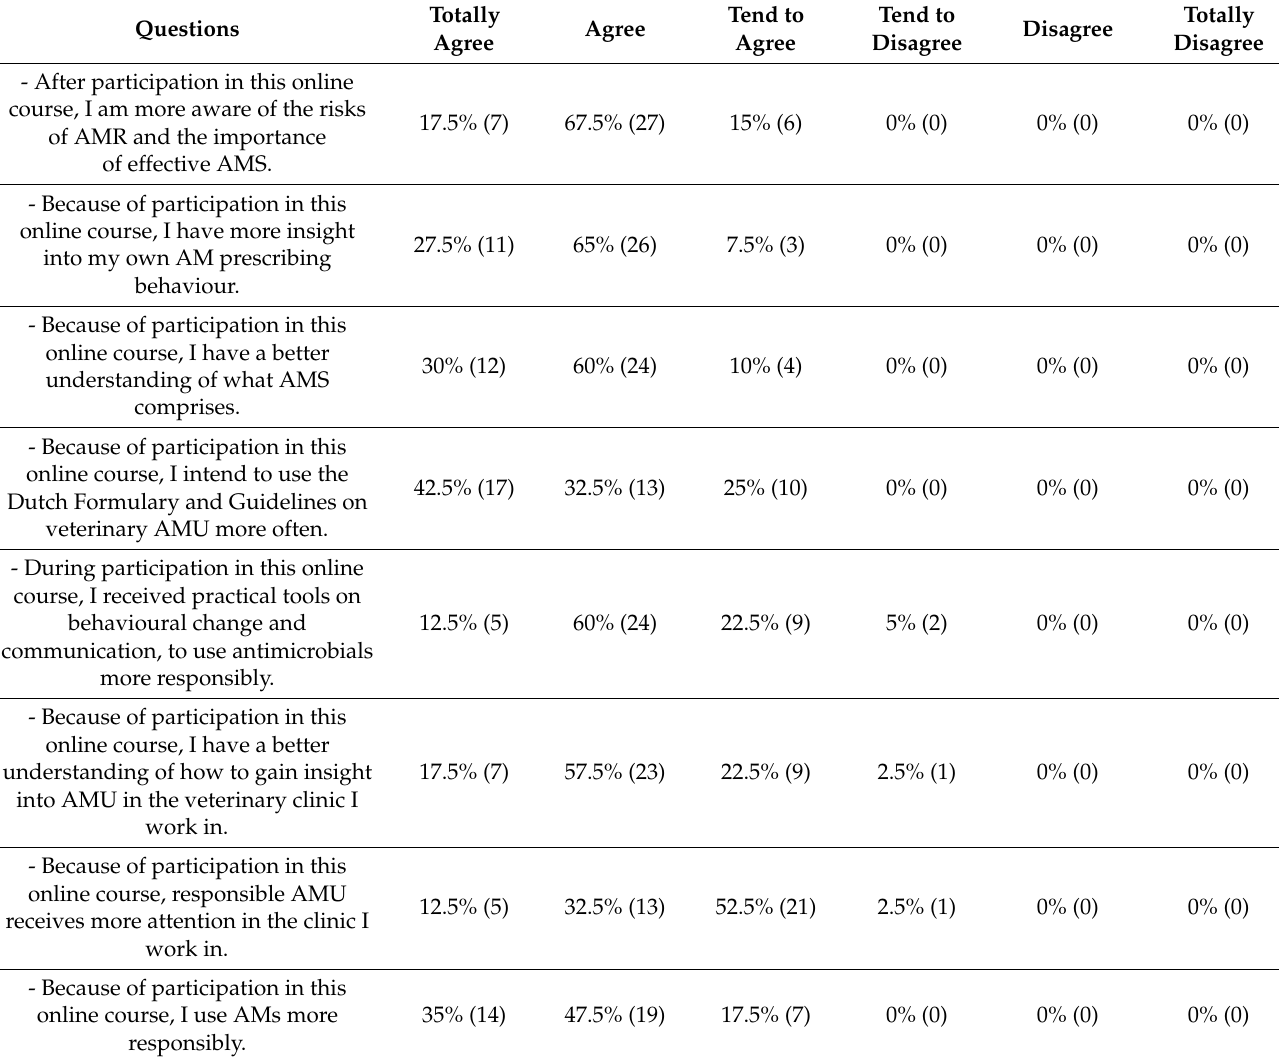
Table 2. Questions to evaluate achievement of the learning objectives of the online course. Questions were scored on a 6-point Likert scale (expressed in percentage and number of participants).